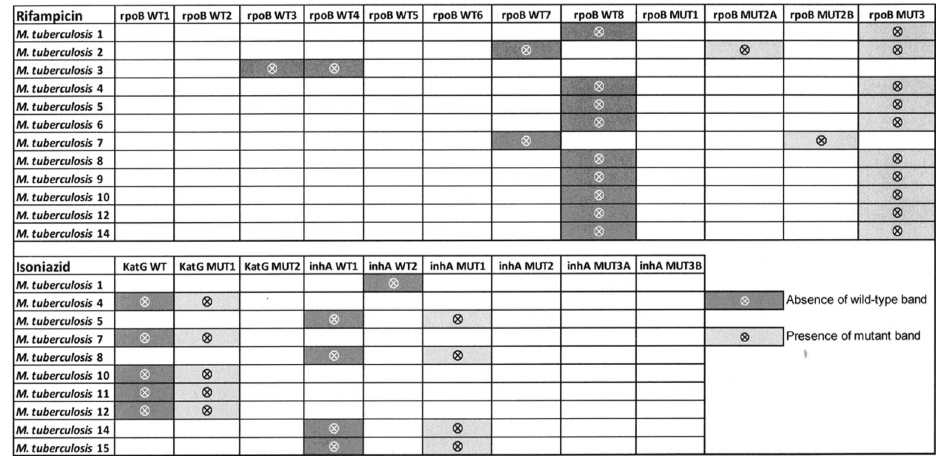
Figure 1. Schematic representation of the Genotype MTBDR plus results in isolates resistant to rifampicin and/or isoniazid.